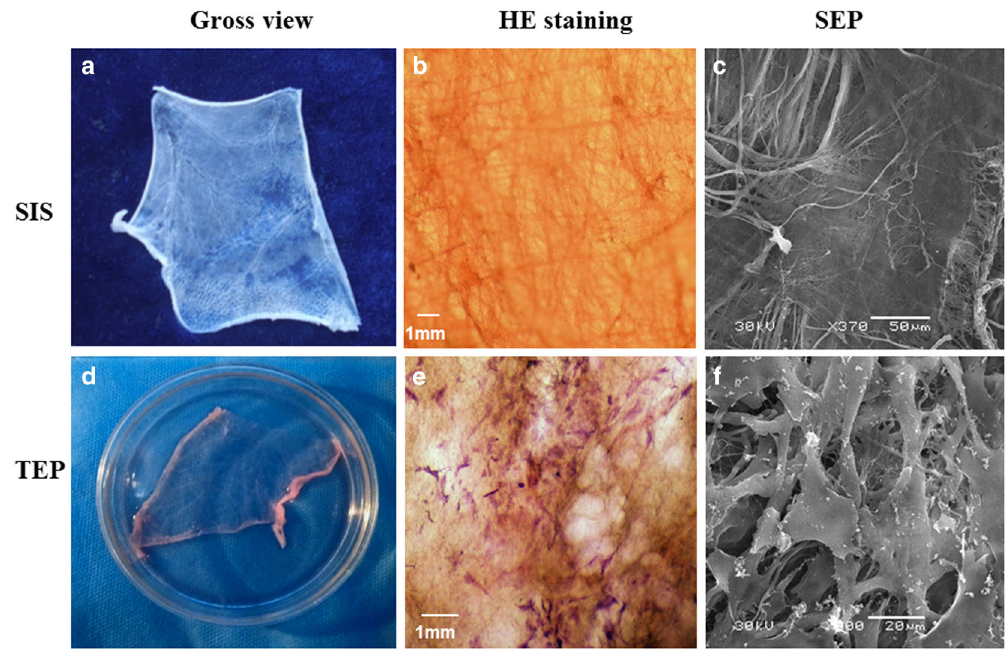
Fig. 3 SIS evaluated under macroscopy ( a ), HE staining ( b ) and SEM ( c ). TEP inspected under macroscopy ( d ), HE staining ( e ) and SEM ( f